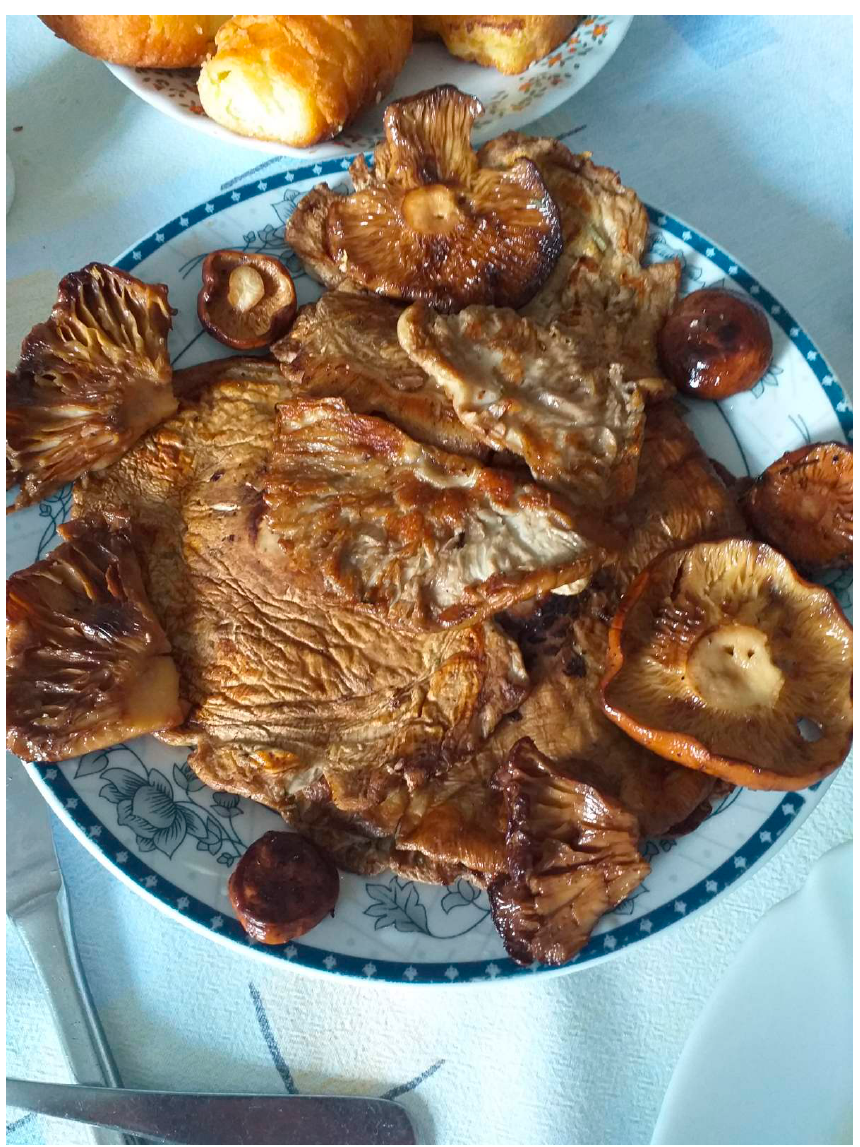
Figure 2. Grilled Macrolepiota procera and Lactarius volemus prepared by informants during the in- vestigation. the